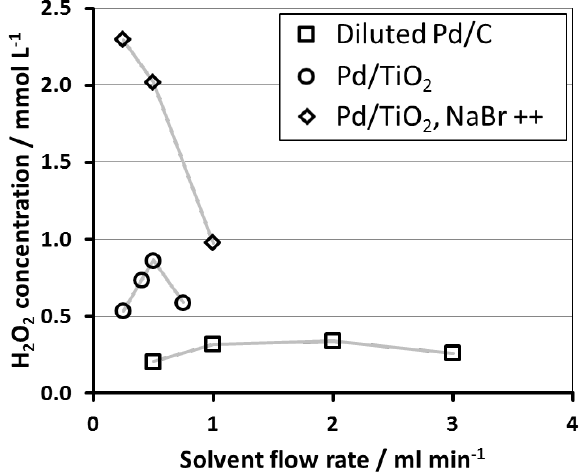
Figure 1. Hydrogen peroxide concentration over solvent flow rate using micro channel fixed beds in a 0.5 mm deep micro channel and a 180 μm Nafion ® membrane at 20 bars system pressure with water as solvent: squares: Diluted Pd/C, solvent with 0.15 mM NaBr and 0.15 mM H 2 SO 4 (Table 1 Exp.-Nr.: 1–4), circles: Pd/TiO 2 , solvent with 0.15 mM NaBr and 0.15 mM H 2 SO 4 (Table 1 Exp.-Nr.: 5–9), diamonds: Pd/TiO 2 , solvent with 4 mM NaBr and 0.15 mM H 2 SO 4 (Table 1 Exp.-Nr.: 10–12).